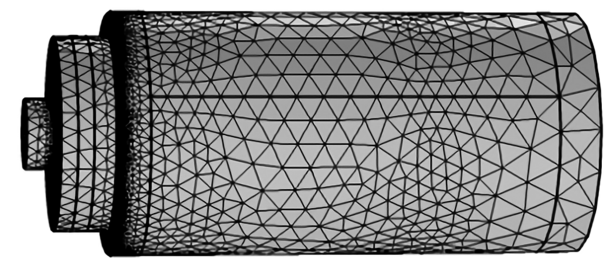
Figure 11. Gridding of the motorized